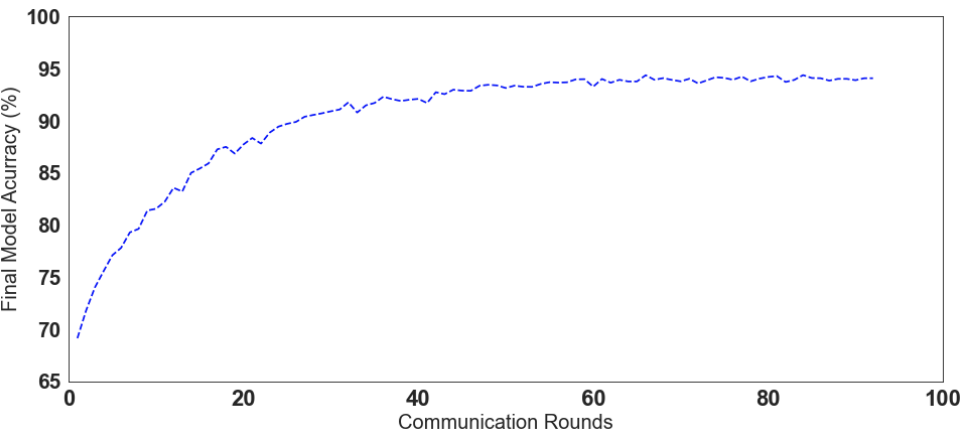
Figure 13. Collaborative training accuracy using the FEDn framework.